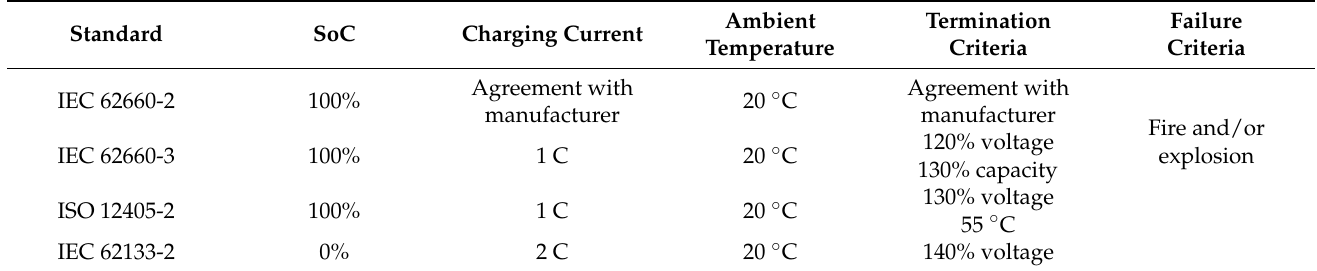
Table 2. Comparison of the parameters for an overload [9–12].